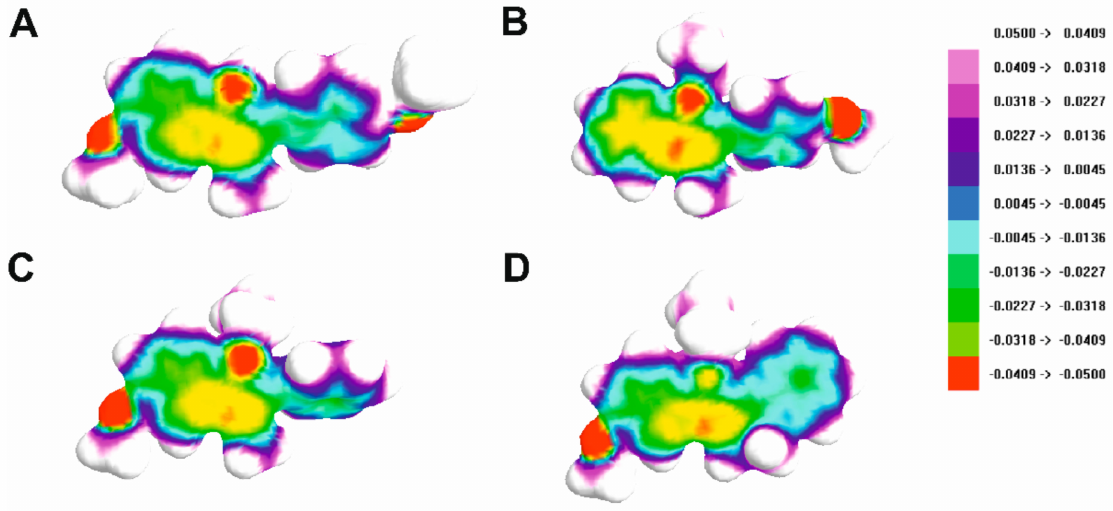
Figure 11. Electrostatic potential surface for compounds 1 ( A ), 2 ( B ), 3 ( C ) and 4 ( D ).